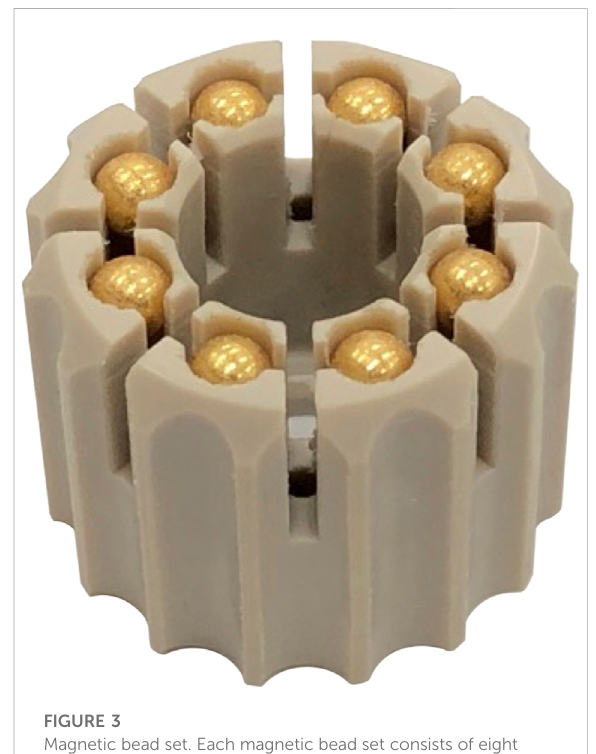
FIGURE 3 Magnetic bead set. Each magnetic bead set consists of eight coated, cleaned, and magnetized beads subsequently inserted intoamagneticbeadcartridgeforpackaging,sterilization,storage, and deployment. The surgeon deploys the magnetic beads directlyfromthecartridgeusingthecustomHalifaxmagneticbead insertion device (see Figure 4).